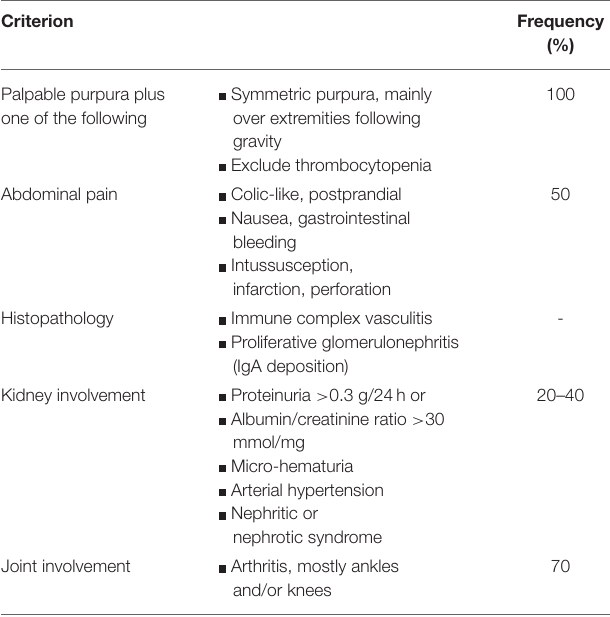
TABLE 4 | EULAR/PRINTO/PRES diagnostic criteria for Henoch-Schönlein Purpura diagnosis. Criterion